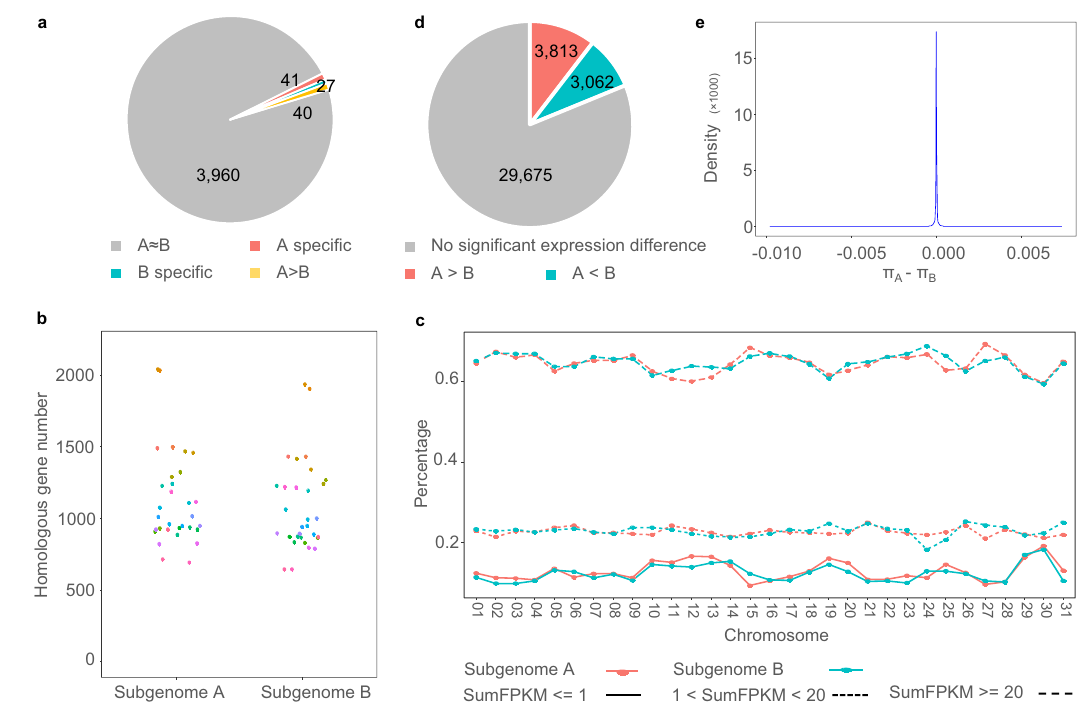
Fig. 5 Comparison of dominance between subgenomes A and B. a The counts of genes containing each Pfam domain are compared between subgenomes A and B. The Pfam domains are classi fi ed into “ A ≈ B ” (contained gene counts are not signi fi cantly different), “ A speci fi c ” (only contained by subgenome A), “ B speci fi c ” (only contained by subgenome B), and “ A > B ” (contained by more genes in subgenome A). b Comparison of chromosomal homologous gene numbers between subgenomes A and B. Scutellaria barbata was used as an outgroup. Wilcoxon test was performed with two-sided alternative hypothesis. c Comparison of Scutellaria barbata homologous gene expression between subgenomes A and B. Genes were classi fi ed into three groups according to their total expression value in 18 RNA-seq datasets. The percentage of each group was compared for each chromosome. FPKM is an abbreviation for Fragments Per Kilobase Million. d Comparisons of the expression of genes in each intersubgenome syntenic gene pair. T -test were performed with two-sided alternative hypothesis. Gene pairs are classi fi ed into “ No signi fi cant expression difference ” , “ A > B ” (genes from subgenome A highly expressed than corresponding genes from subgenome B), and “ A < B ” (genes from subgenome B highly expressed than corresponding genes from subgenome A). e Kernel density plot for the differences in genetic diversity between genes belonging to intersubgenome syntenic gene pairs. Source data are provided as a Source Data fi